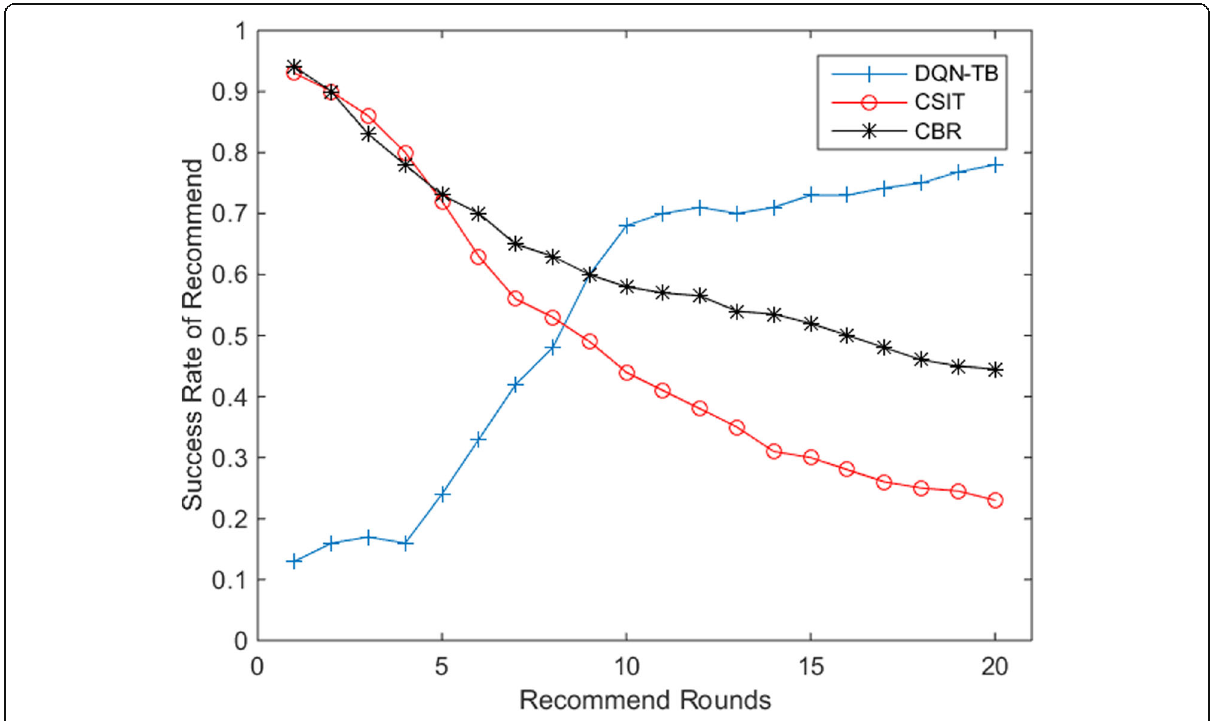
Fig. 14 Change of success rate in the recommend system